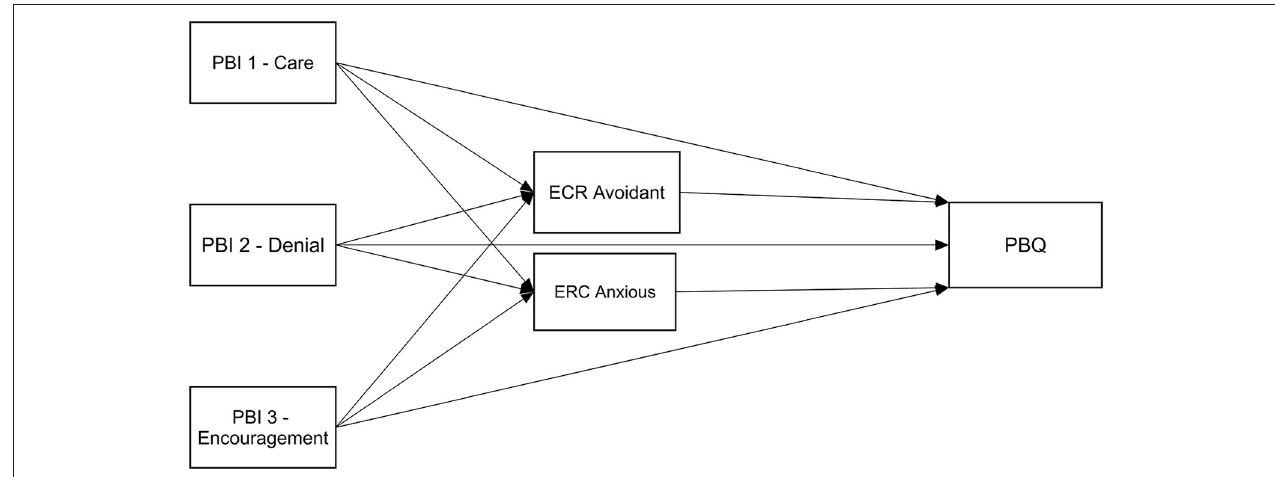
FIGURE 1 | Hypothesized mediation model; Insecure attachment orientations (ECR) will mediate the association between parental bonding (PBI) and mother-infant bonding